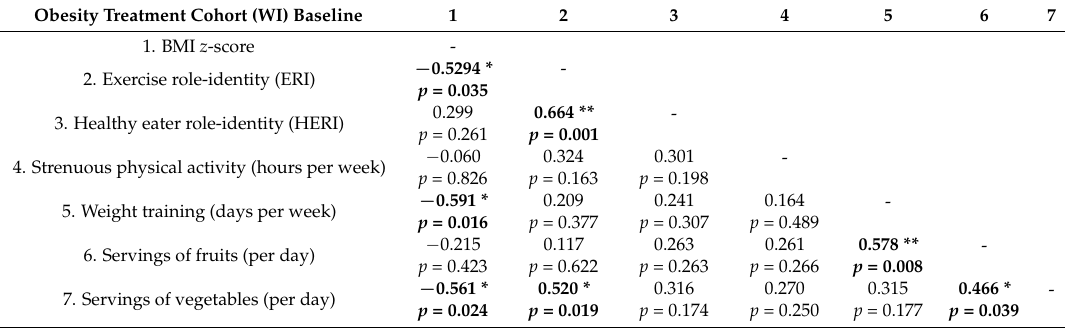
Table 5. Pearson coefficient and p value of select variables demonstrating baseline correlations between BMI and ERI (negative; moderate), ERI and HERI (positive; moderate), weight training and BMI (negative; moderate), servings of vegetables per day and BMI (negative; moderate), and servings of vegetables per day and ERI (positive; moderate) in the obesity treatment cohort.